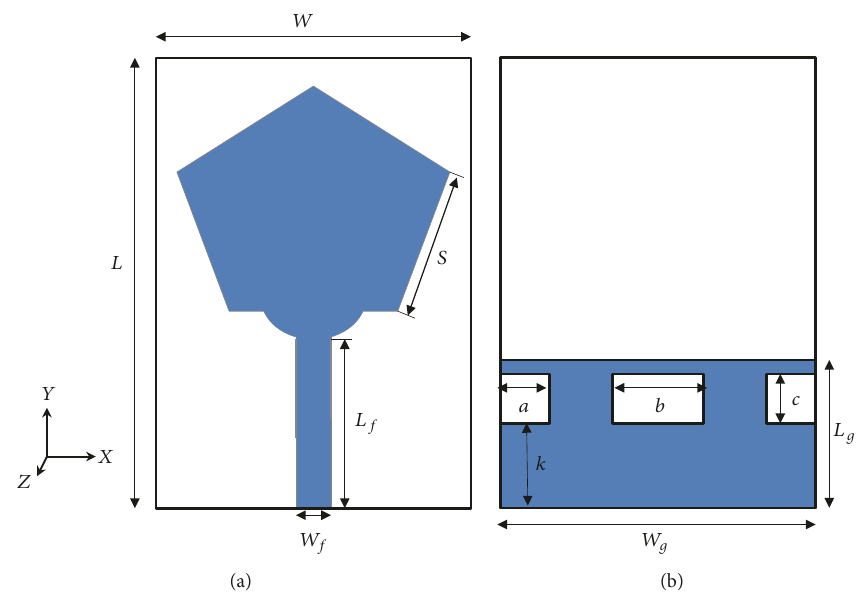
Figure 1: Geometry of the antenna: (a) front view and (b) bottom view.